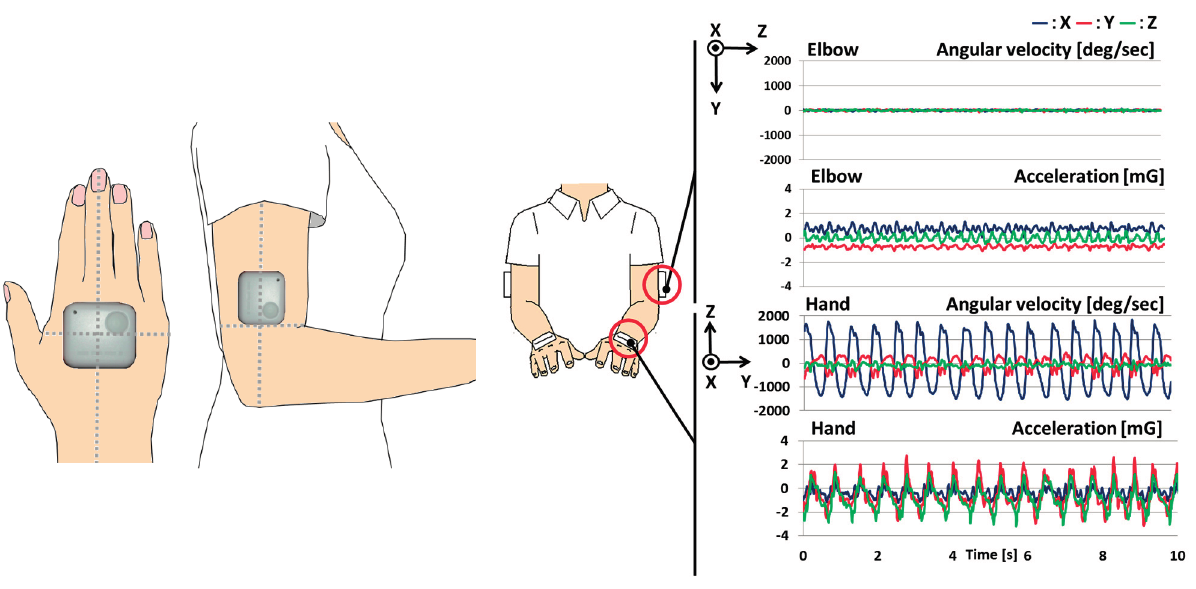
Figure 2. The position of sensors and example waveforms from the sensors in each of the three axes during pronation and supination of the